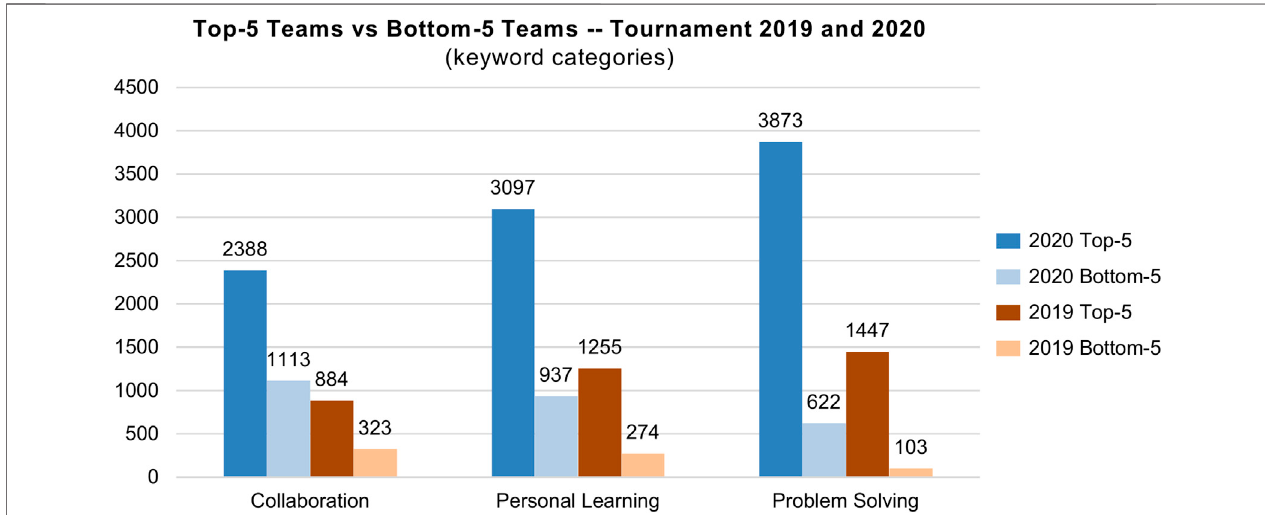
FIGURE 1 | Keyword frequencies of the top-5 and bottom-5 teams of the 2019 and 2020 eTournaments.